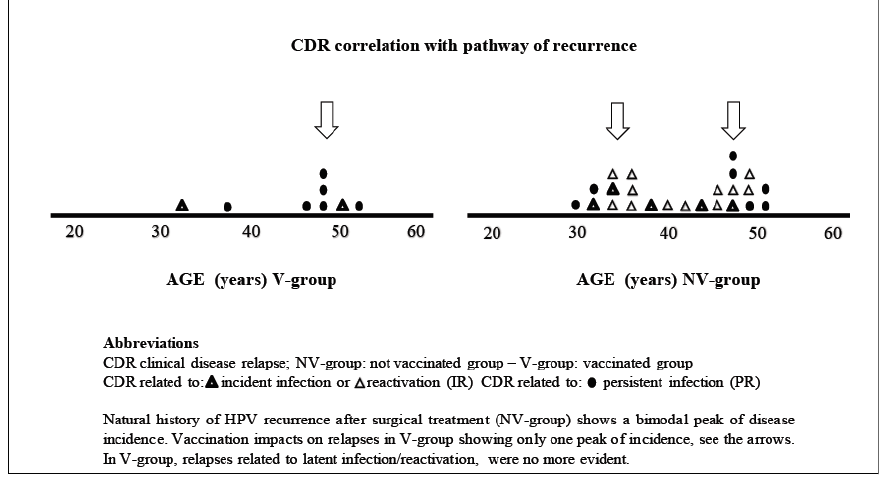
Figure 4. CDR subgroup analysis << Persistent/Incident recurrence